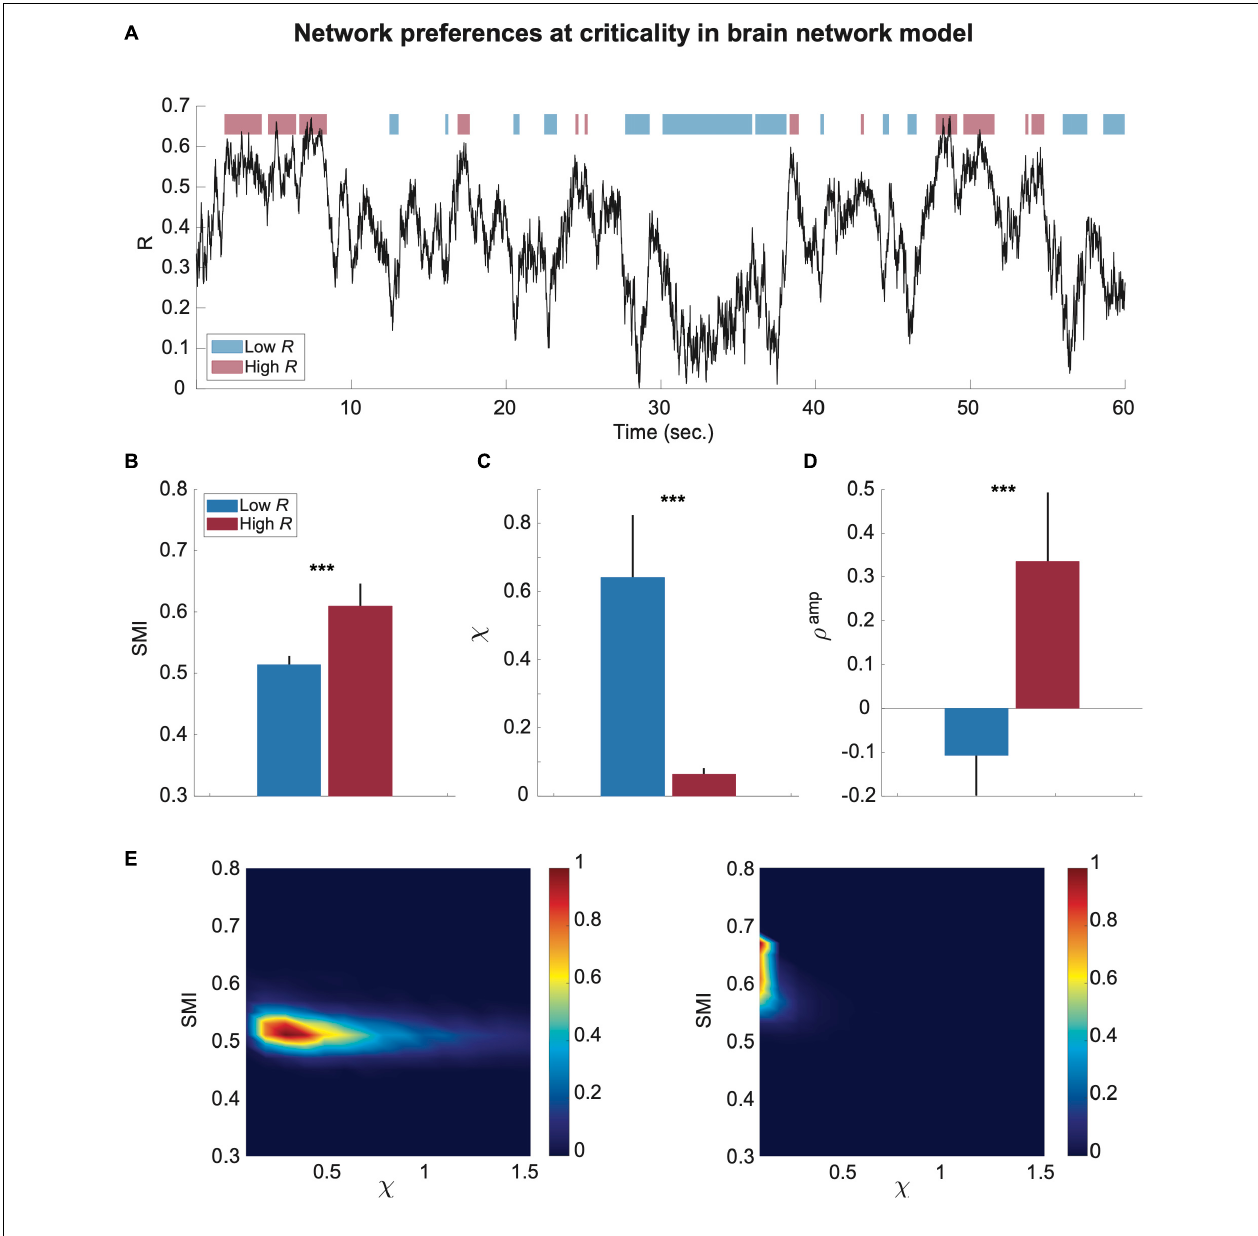
FIGURE 3 | The preferences of the brain network for internal information integration and external responsiveness are prominent in sub-second time windows (250-ms) in the model. (A) An example of a network synchronization fluctuation near a critical state. Red and blue bars indicate temporal windows classified into low and high R. The SMI, χ , and S amp were calculated for each window. Comparisons of (B) SMI, (C) χ , and (D) S amp between temporal windows of low R (blue) and high R (red) are presented. The black lines of the colored bars indicate from 25% to 75% quantiles. A Wilcoxon rank-sum test was performed (*** p < 0.001). (E) Joint histograms of the low (left) and high (right) R windows. The low R window is characterized by relatively low SMI and high χ , while the high R window is characterized by relatively high SMI and low χ